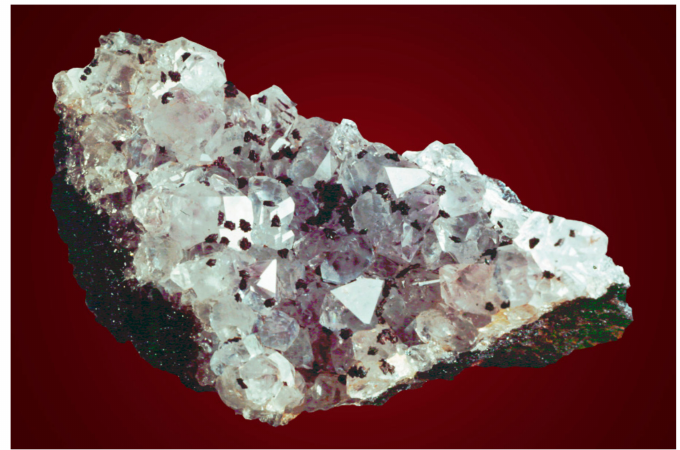
Figure 24. Quartz, hematite inclusions, Bowman prospect. 8 cm. Chamberlain Collection, NYSM C4662.